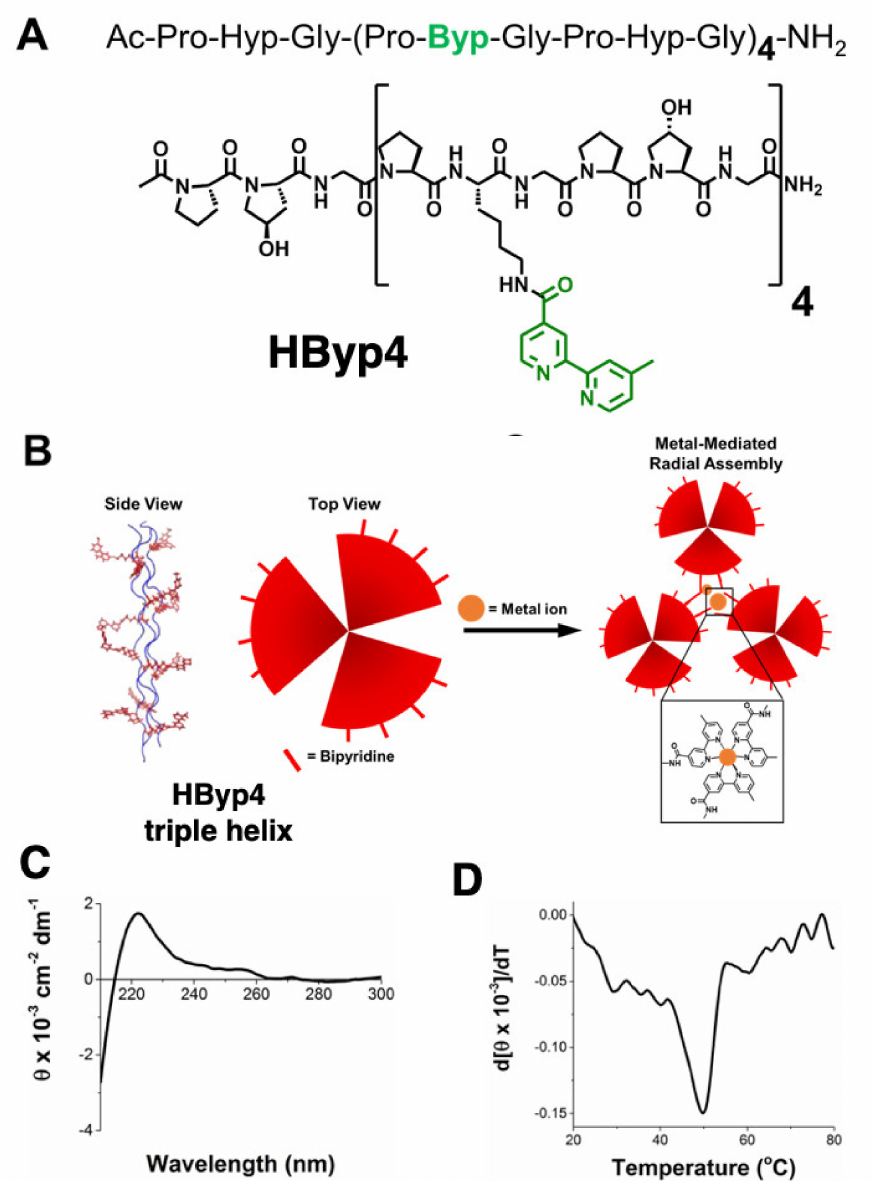
Figure 1. ( A ) The structure of HByp4; ( B ) metal ion-promoted assembly of the trimeric coiled coil; ( C ) CD spectrum of HByp4 (150 µ M, 10 mM HEPES, pH 7.0); ( D ) first derivative of melting curve to determine the T m value for